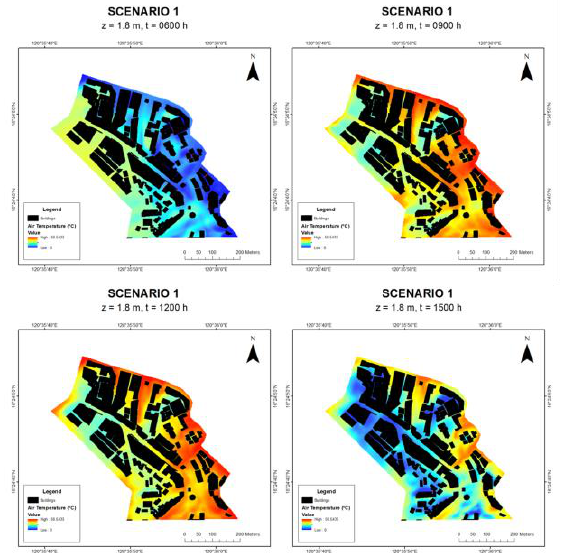
Figure 7. Simulated air temperature at 1.8m for the current scenario (Scenario 1) during 6:00, 9:00, 12:00 and 15:00 hours in lower Session Road, Baguio City.